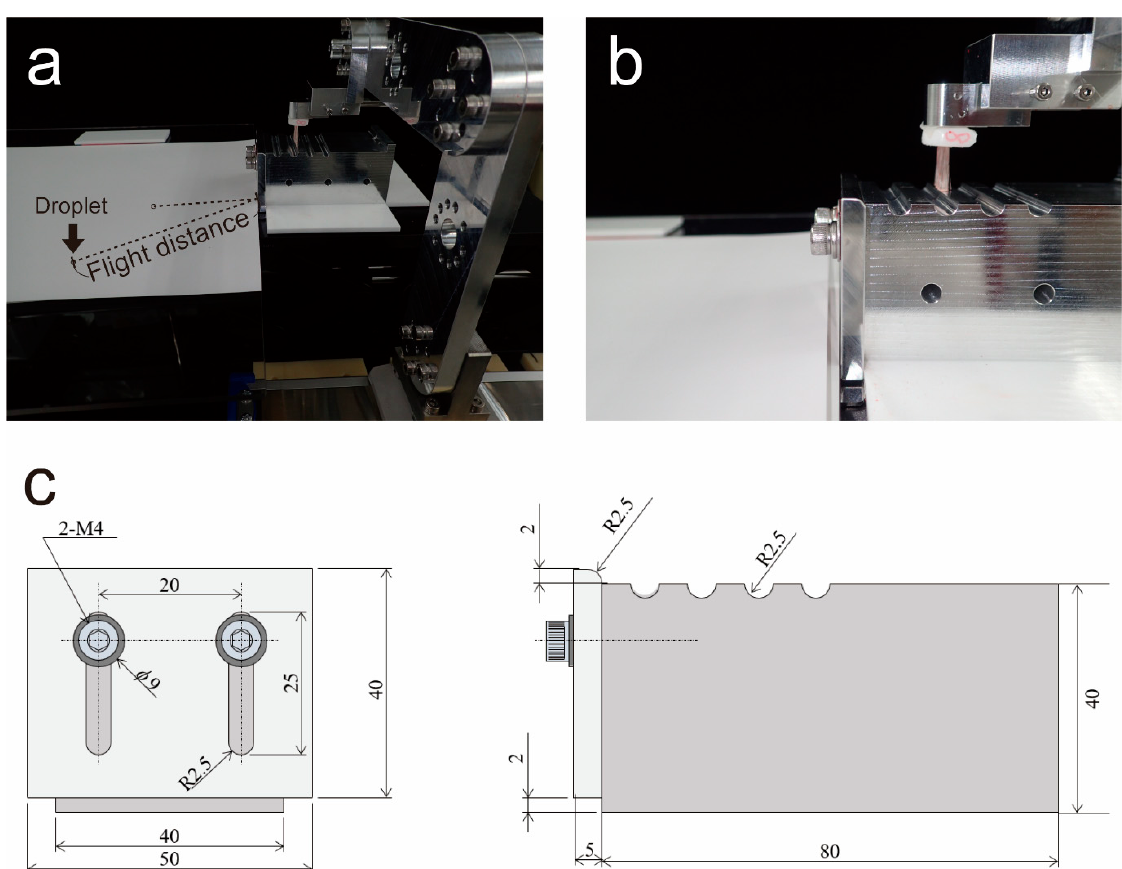
Figure 1. Overview of the droplet evaluation model using a single-axis robot. ( a ) Photograph of the uniaxial robot. A toothbrush head was attached to the arm, which repeated linear motion at constant velocity. The droplet generation unit at the bottom of the arm caused the brush to bend and droplet droplets generated were recorded on A4 paper. The linear distance between the droplet’s generated point and the droplet fell point was measured as the flight distance; ( b ) an image of the droplet generation unit is presented. The deflection of the toothbrush head could be adjusted by reproducing the palatal side of the maxillary anterior teeth and changing the height of the step at the tip. Using a number of grooves in the droplet generation unit allows removal of excess liquid and ensures that the amount of toothpaste adheres to the brush uniformly; ( c ) schematic diagram of the droplet generation unit. The distance is shown in mm. ф mean diameter; 2-M4 means to use two 4 mm diameter screws.